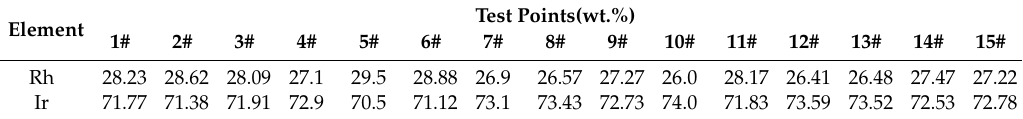
Figure 2. SEM images and electron-probe microanalysis (EPMA) maps of alloys before oxidation. SEM images of ( a ) IrRh10 and ( b ) IrRh25. EPMA maps of ( c ) IrRh10 and ( d ) IrRh25. Table 3. Energy-dispersive spectrometry (EDS) analysis results of IrRh25.